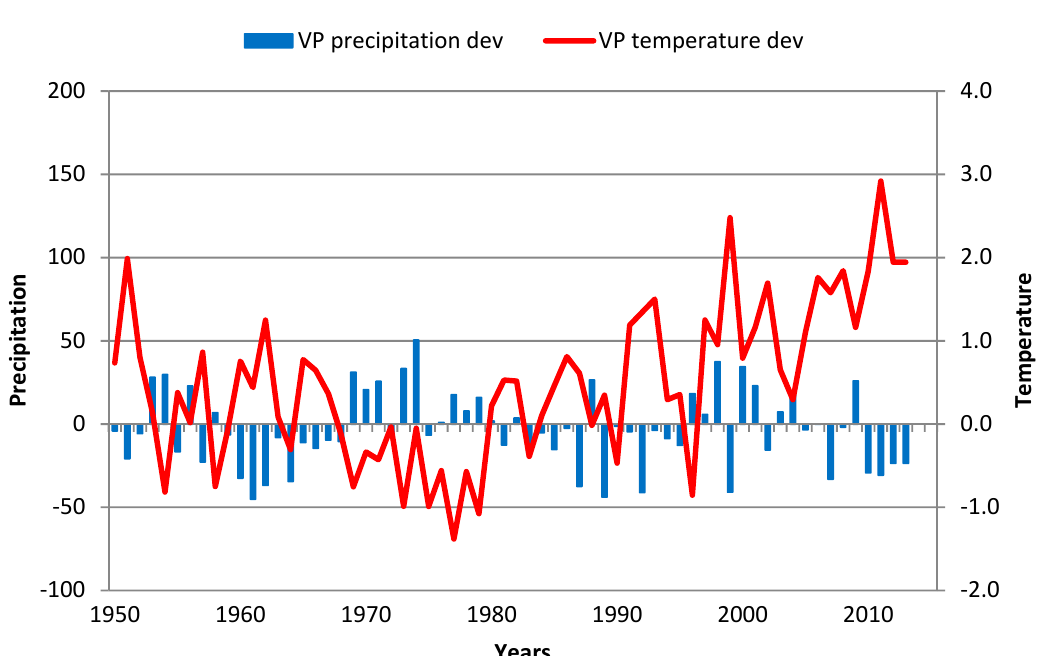
Figure 7. GS precipitation and temperature deviations in Kosmaj over the 1951–2013 period. Red line—GS temperature deviation; blue bars—GS precipitation deviation.